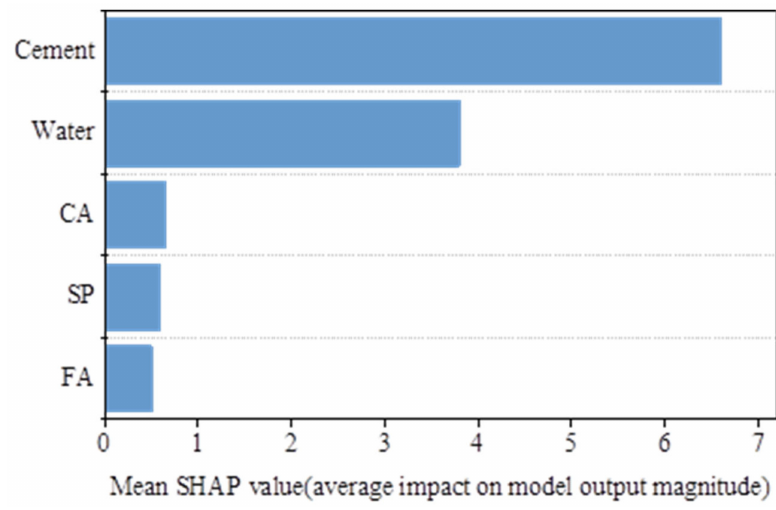
Figure 8. Global importance of the input